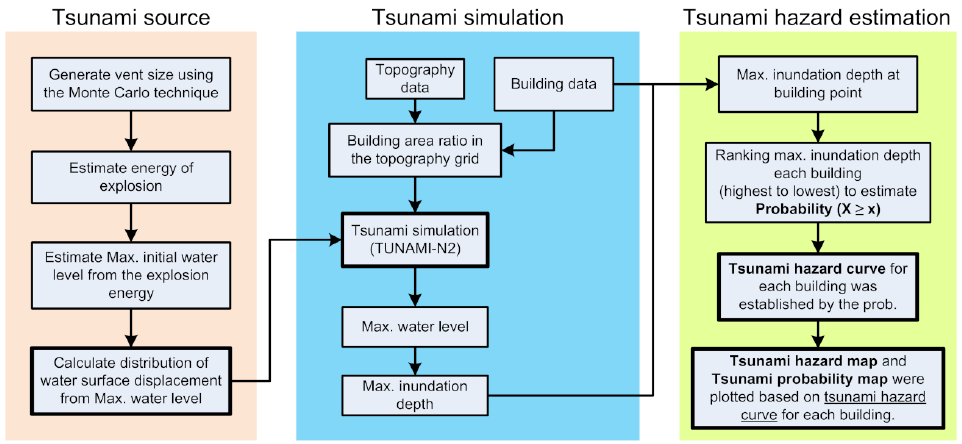
Figure 2. Flow chart of this study used to achieve probabilistic tsunami